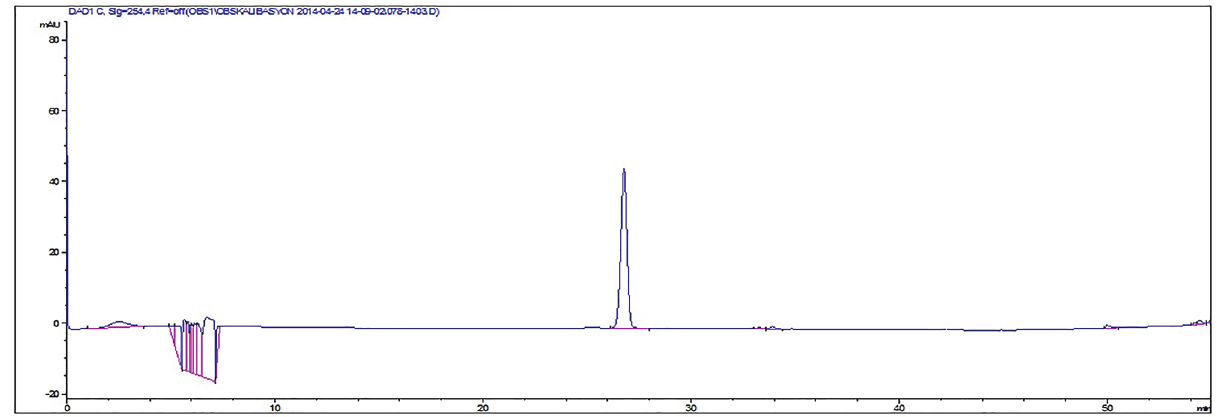
FIGURE 3 - HPLC chromatogram of